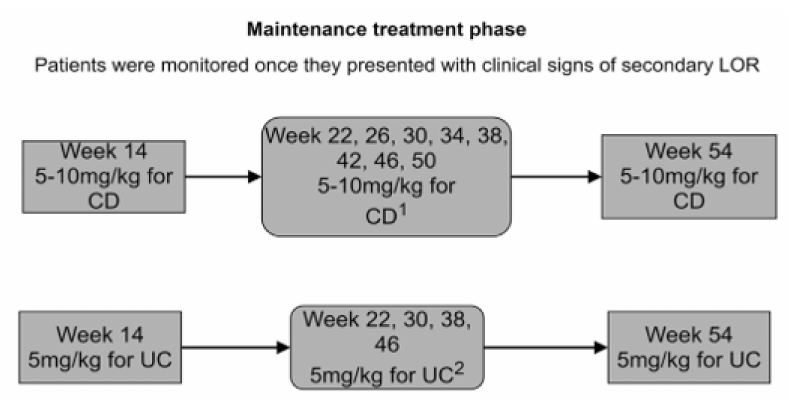
Figure 3. CT-P13 dosing and drug level testing schedule in group